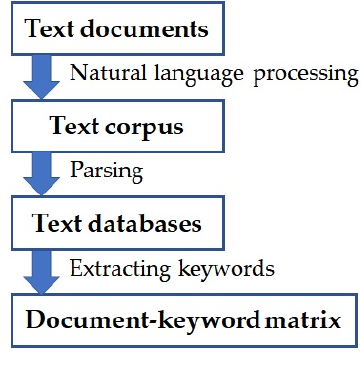
Figure 2. Text ‐ mining process. Figure 2. Text-mining process. Table 1. Patent keyword